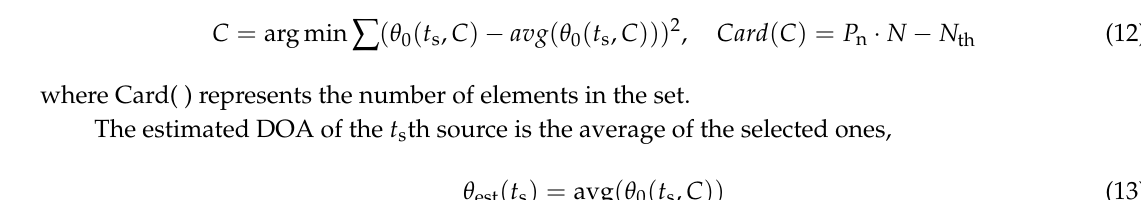
Algorithm 2: DOA estimation and statistical